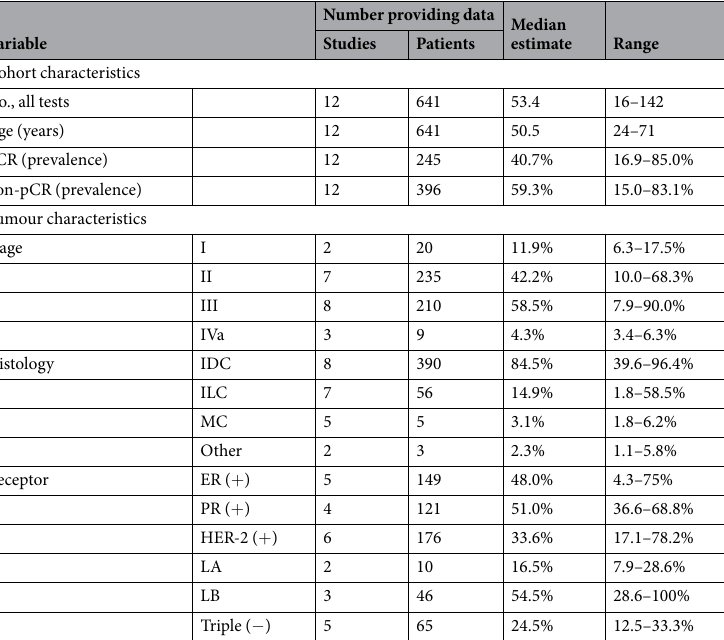
Table 1. Summary of the cohort, tumour, and treatment characteristics of the included studies. ER = oestrogen receptor; PR = progesterone receptor; HER2 = human epidermal growth factor receptor 2; IDC = invasive ductal carcinoma; ILC = invasive lobular carcinoma; MC = mucinous carcinoma; LA = luminal A; LB = luminal B; NAC = neoadjuvant chemotherapy; NR = not reported; pCR = pathologic complete response; Triple ( − ) = Triple